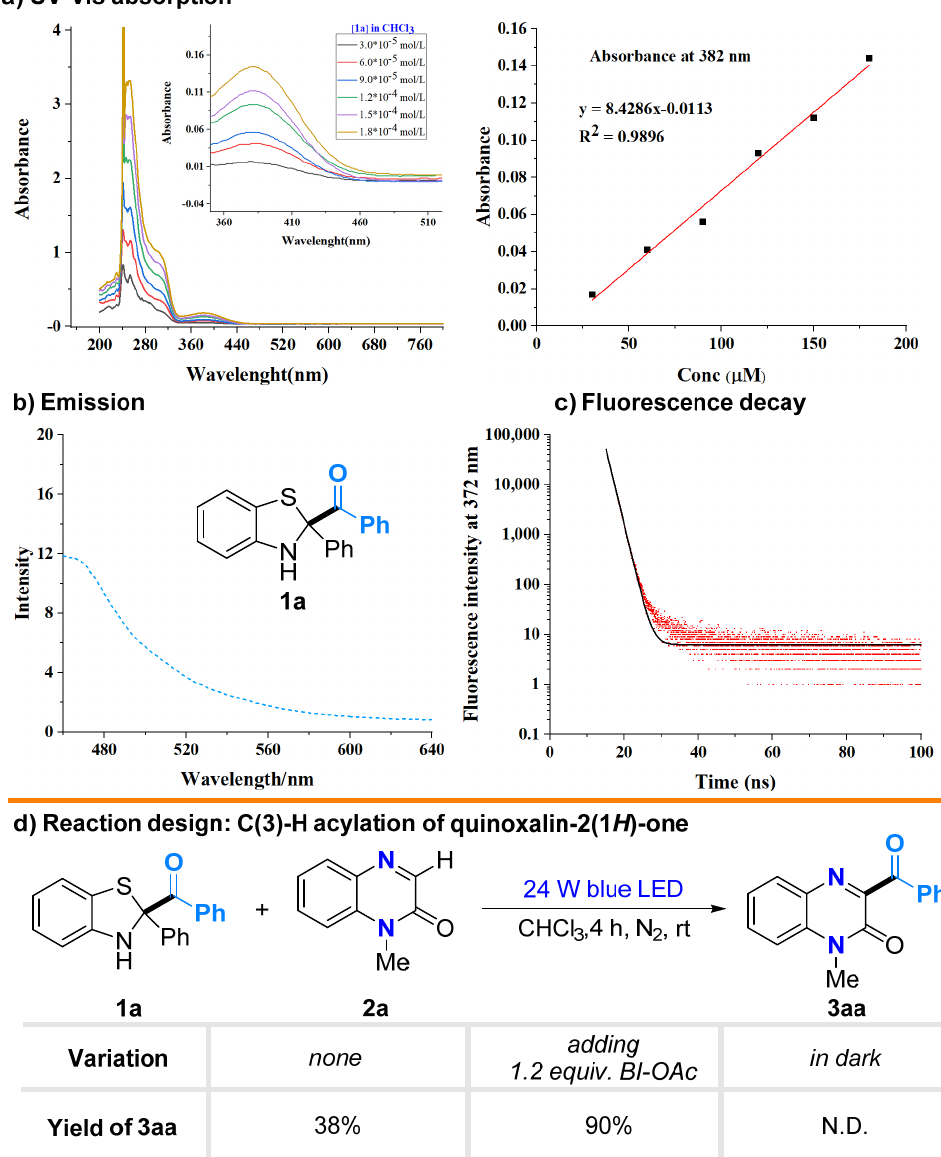
Figure 1. ( a ) Absorption of 1a in CHCl 3 ( λ max = 382 nm). ( b ) Emission of 1a in CHCl 3 (excitation at 420 nm). ( c ) Fluorescence decay trace of 150 μ M 1a in CHCl 3 after pico-second photoexcitation at 372 nm. ( d ) Direct photoexcitation of 1a in C3-H acylation of quinoxaline-2-(1 H )-one.